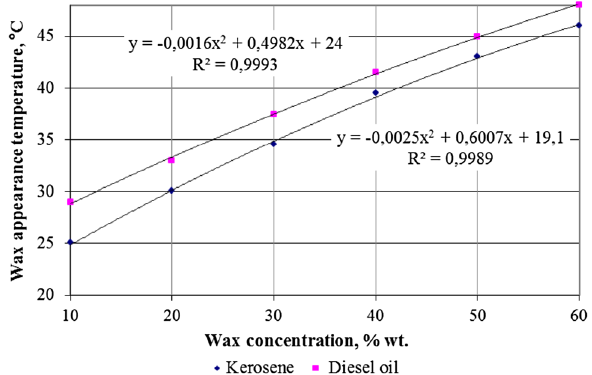
Fig. 2 Effect of wax concentration on WAT in the wax-bearing solu- tions by visual